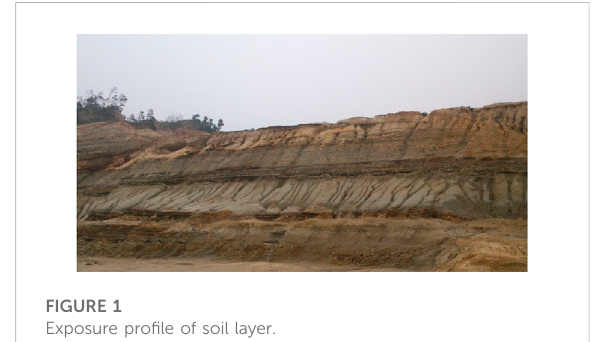
FIGURE 1 Exposure pro fi le of soil